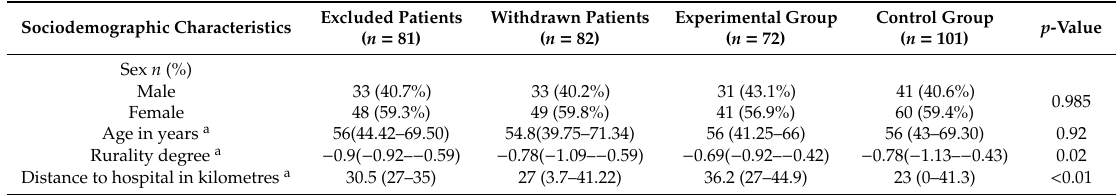
Table 2. Sociodemographic characteristics of the included and excluded patients by groups.